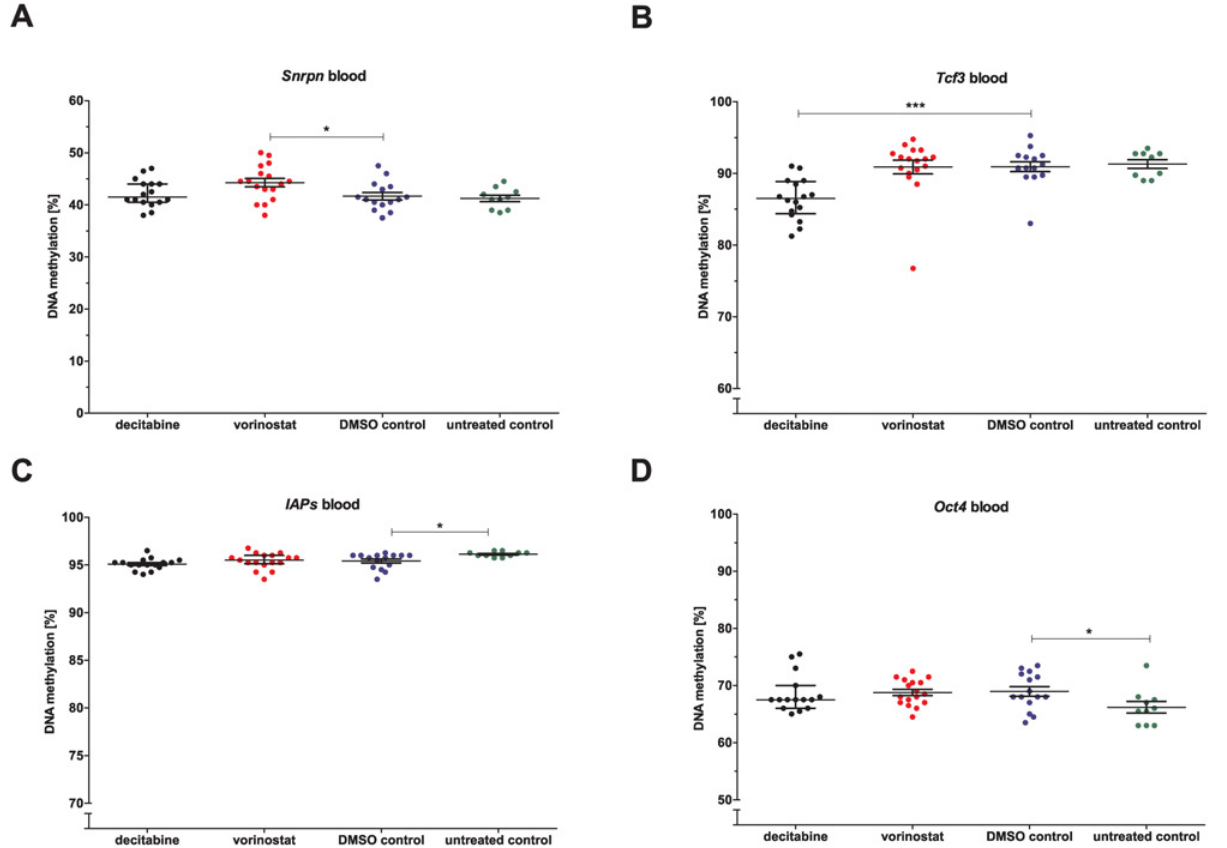
Fig 3. Direct effects of decitabine and vorinostat on DNA methylation in blood of the P-generation. Genes: A) Snrpn , B) Tcf3 , C) IAPs and D) Oct4 . Statistical differences were calculated for decitabine and vorinostat in comparison to DMSO vehicle control and for DMSO vehicle control in comparison to untreated control mice. One point represents one animal. The median ( ± interquartile range) is shown for each group, * : p < 0.05, ** : p < 0.01, *** : p < 0.001, **** : p < 0.0001.